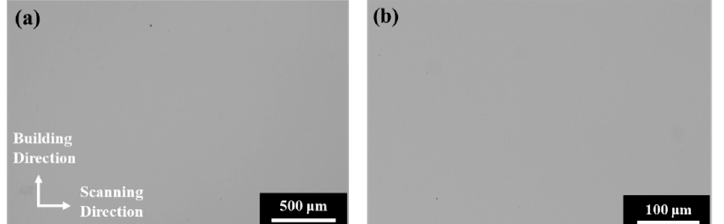
Figure 1. Optical micrographs of the as-fabricated GH3536 superalloy horizontal to building direc- tion. ( a ) in low magnification, ( b ) in middle magnification. ( a ) in low magnification, ( b ) in middle